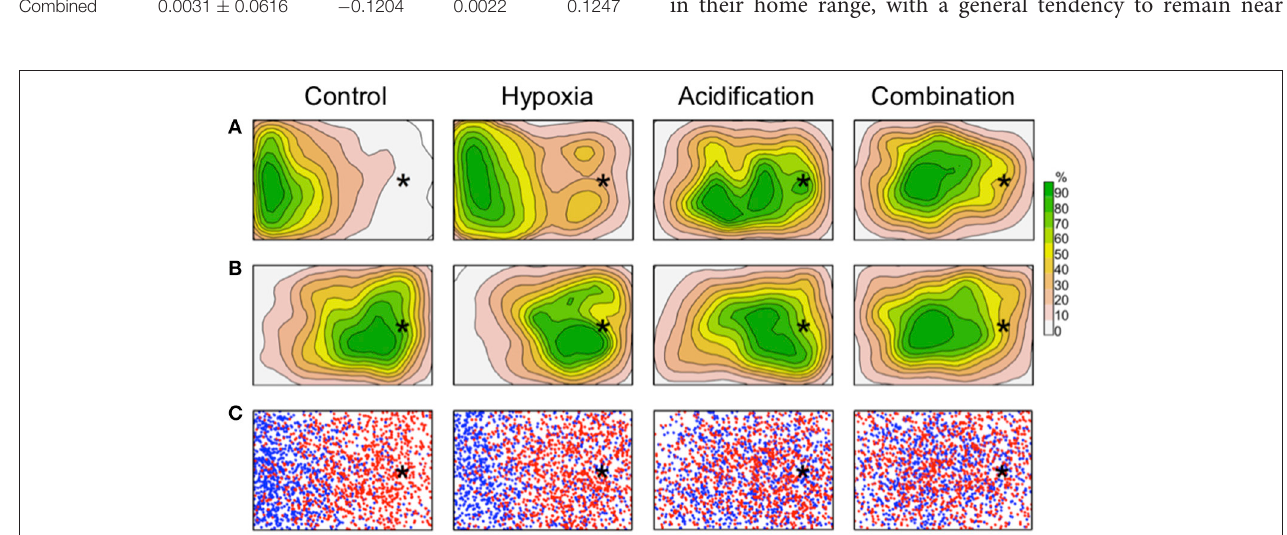
FIGURE 1 | Behavioral response shown as 2-dimensional kernel density plot. The model shows behavioral response to the 4 treatments before (A) and after introduction of the simulated predator (B) Lower graphs (C) show a simulated distribution before (blue) and after (red) the predator was introduced to the arenas (after the model developed by Palmer et al. (2009). The stars mark the position of the shelter. Simulated predator, food, and aeration were positioned at the left side of the arenas (not visible in the square).